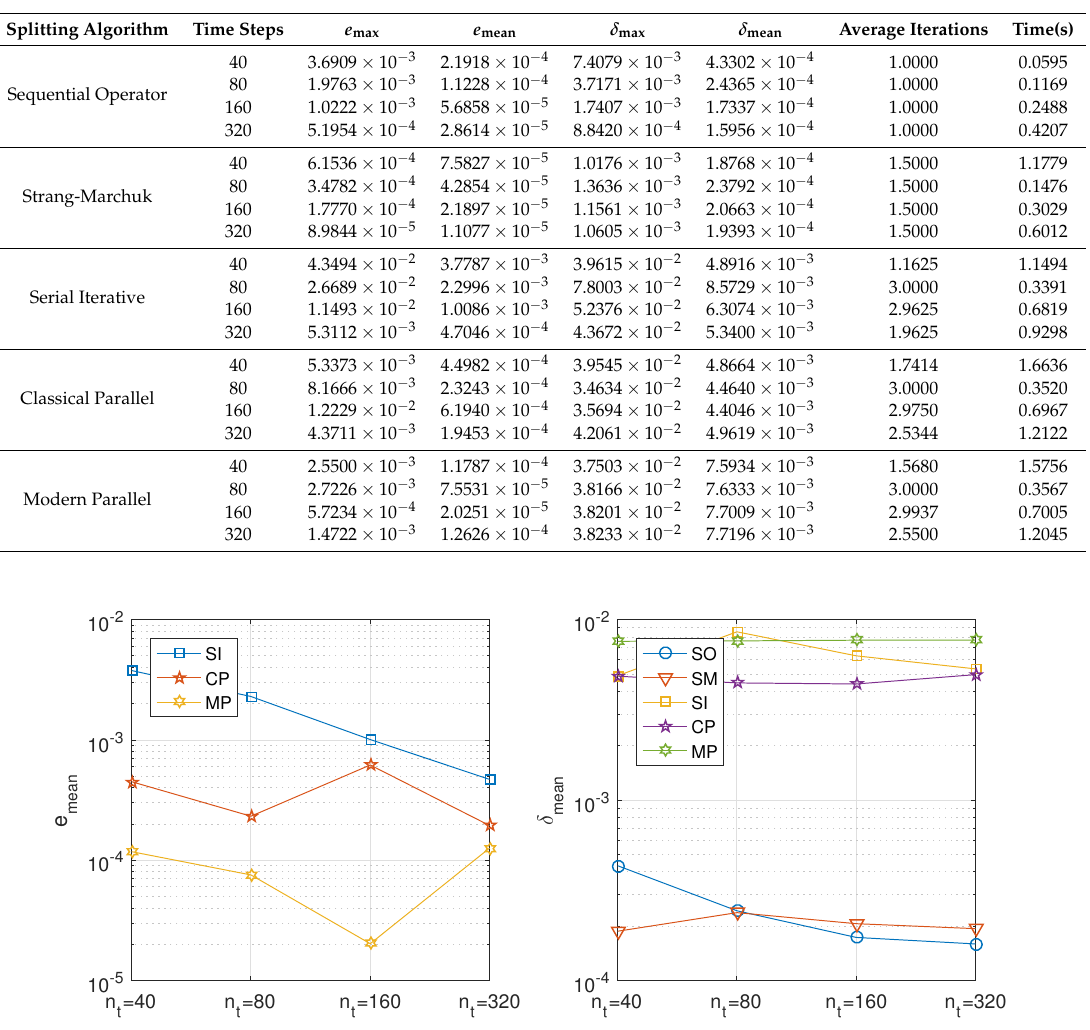
Figure 15. Fractional diffusion equation, directional decomposition. Precision of the proposed methods: sequential iterative SI, classical parallel CP, and modern parallel MP, compared with the classical ones: sequential operator SO and Strang–Marchuk SM, for different number of time